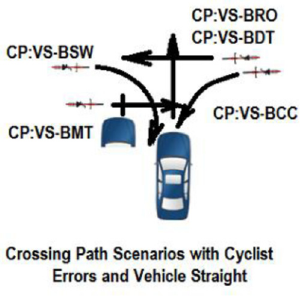
Figure 6 Crash geometry of CP:VS scenarios